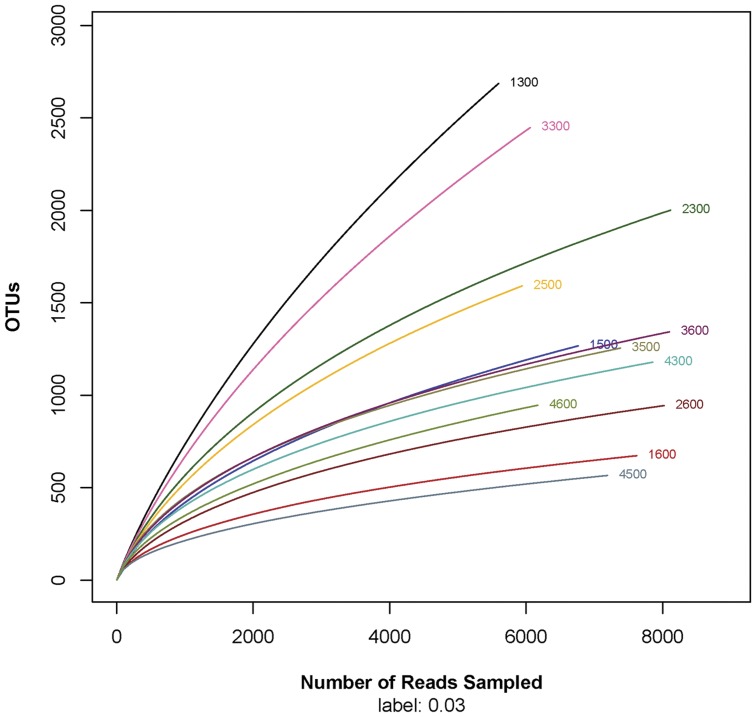
Rarefaction analysis of the different samples.Rarefaction curves of OTUs clustered at 97% phylotype similarity level. The sample labels beginning with numeric 1, 2, 3 and 4 correspond to the sampling locations of Walagan (WL), Walagan north (WN), Tayuan (TY) and Jiagedaqi (JQ). The second digit (3, 5, 6) in the labels represents the upper, the lower active layer and the permafrost table, respectively.